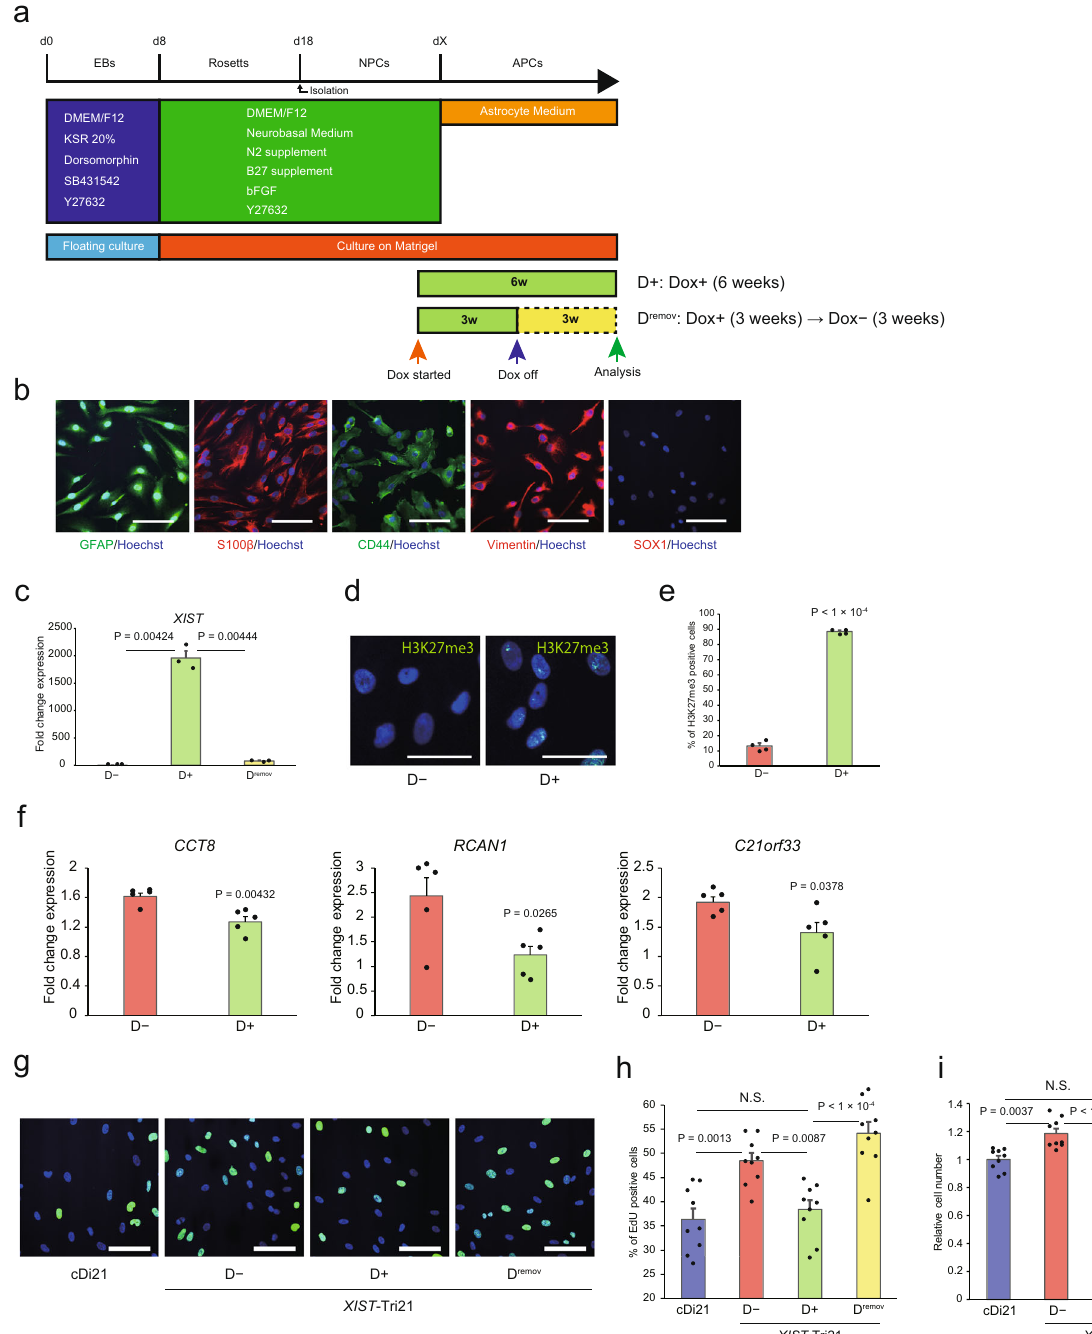
Fig. 2 XIST -mediated chromosome silencing affects the overproliferative phenotype of DS APCs. a Schematic depiction of the differentiation protocol for NPCs and APCs. EBs embryoid bodies. b Immunocytochemistry of XIST -Tri21 APCs using GFAP and S100 β (astrocyte markers), CD44 and vimentin (APC markers), and SOX1 (NPC marker). Nuclei were stained with Hoechst 33342. Scale bars: 100 μ m. c Relative expression levels of XIST RNA in XIST - Tri21 APCs. Expression was normalised to that of D − APCs ( n = 3 experiments per cell line). d Immunocytochemistry of XIST -Tri21 NPCs using an H3K27me3-speci fi c antibody. Nuclei were stained with Hoechst 33342. Scale bars: 50 μ m. e Percentage of H3K27me3-positive cells in XIST -Tri21 APCs ( n = 4 experiments per cell line). f Relative expression levels of genes on chromosome 21 in XIST -Tri21 APCs. Expression levels were normalised to those of cDi21 cells ( n = 5 experiments per cell line). g EdU assay in XIST -Tri21 APCs. EdU-positive cells were stained with an Alexa Fluor 488-conjugated antibody (light green). Nuclei were stained with Hoechst 33342. Scale bars: 100 μ m. h Percentage of EdU-positive APCs ( n = 3 independent differentiation experiments per cell line, performed in triplicate). i Relative numbers of APCs 1 day after seeding. Cell numbers were normalised to those of cDi21 lines ( n = 3 independent differentiation experiments per cell line, performed in triplicate). Data were obtained from three lines ( c , e , f , h , i ). Error bars represent the SEM. Data were analysed by Student ’ s t -test ( e , f ), Welch ’ s two-sample t -test ( c ), or one-way ANOVA with Bonferroni ’ s correction ( h , i ). NS not signi fi cant ( P > 0.05). EdU 5-ethynyl-2 ′